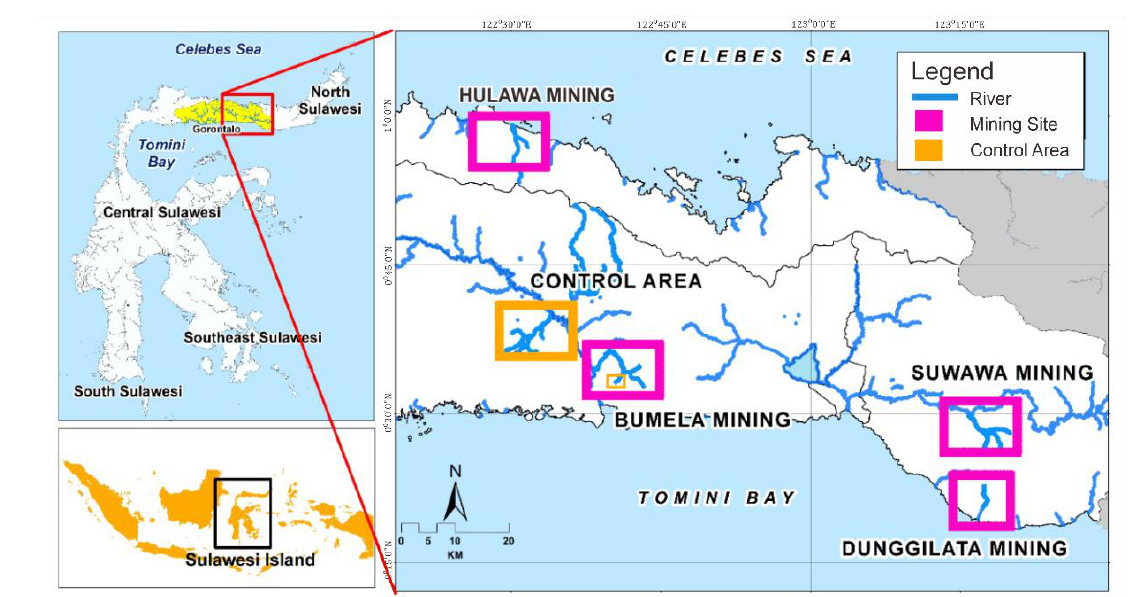
Figure 1. Map of the location of the research area.